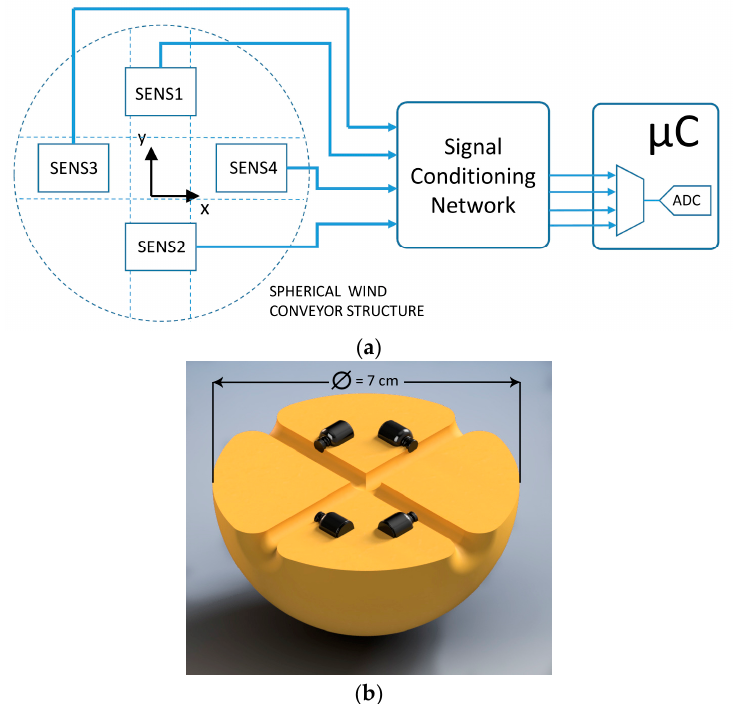
Figure 1. ( a ) block diagram of the proposed anemometric system; ( b ) horizontal half-section view of the implemented spherical structure